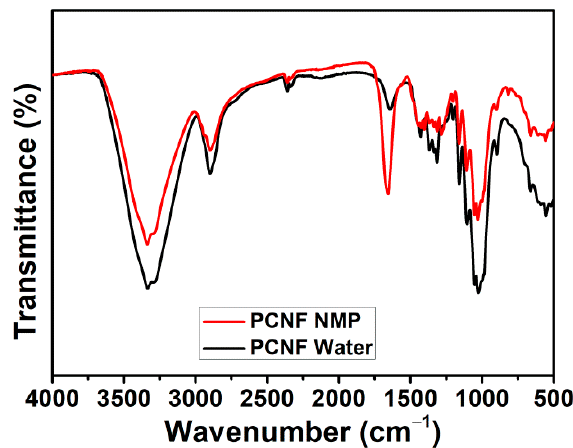
Figure 6. FTIR spectra of PCNF dispersed in water and NMP.